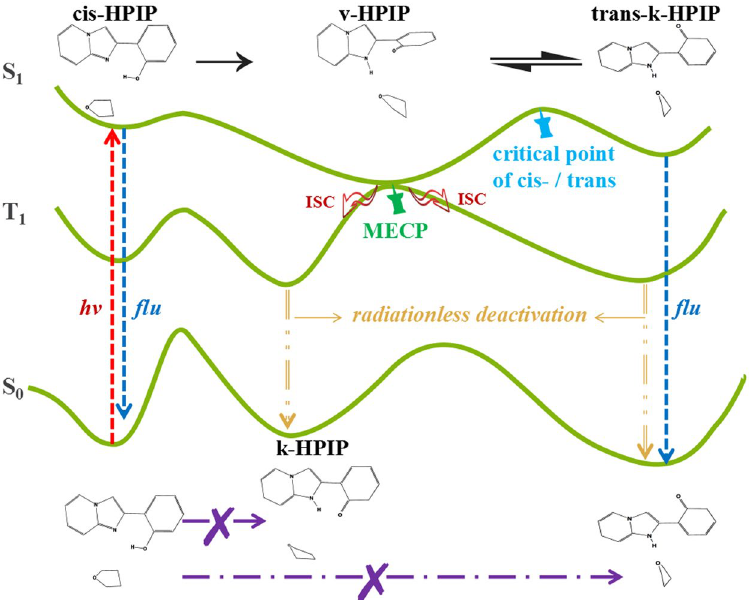
Figure 1. The detailed non-radiative deactivation process.